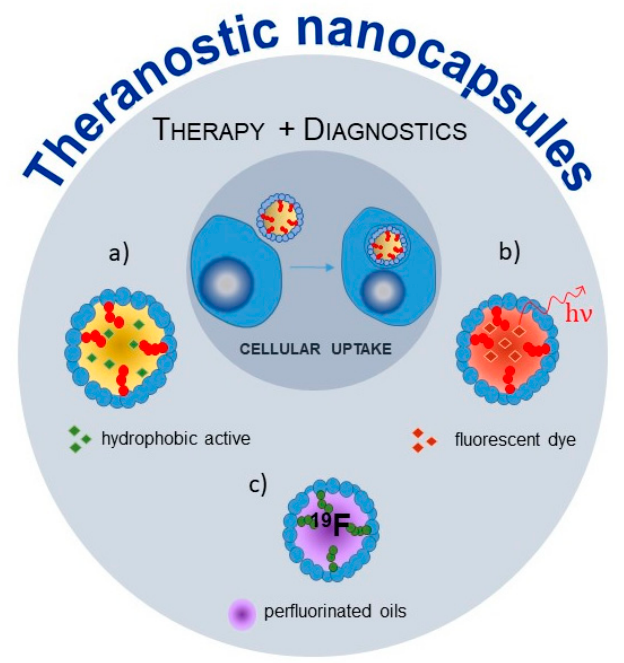
Figure 3. Functionalized nanocapsules for theranostic applications. The hydrophobically modified, polysaccharide-based nanocapsule encapsulating hydrophobic actives in oil core: ( a ) intracellular delivery of hydrophobic actives, ( b ) fluorescent dyes for imaging and capsules detection and ( c ) perfluorinated compounds for 19 F NMR/MRI.